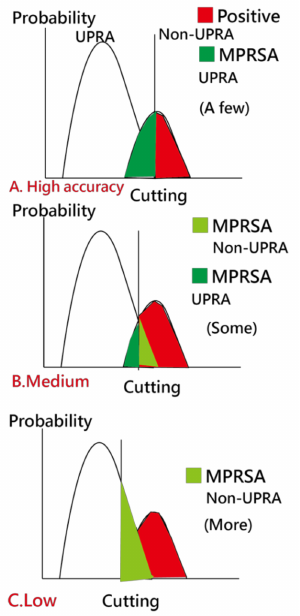
Figure 7. Analysis of the MPRSA